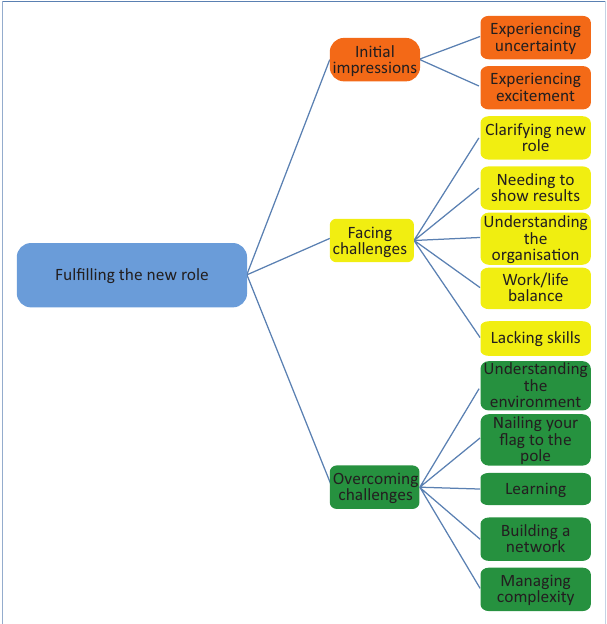
FIGURE 2: Key aspects of fulfilling a new leadership